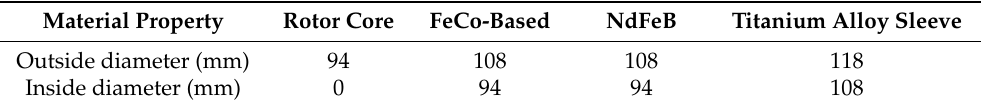
Table 2. Rotor size of